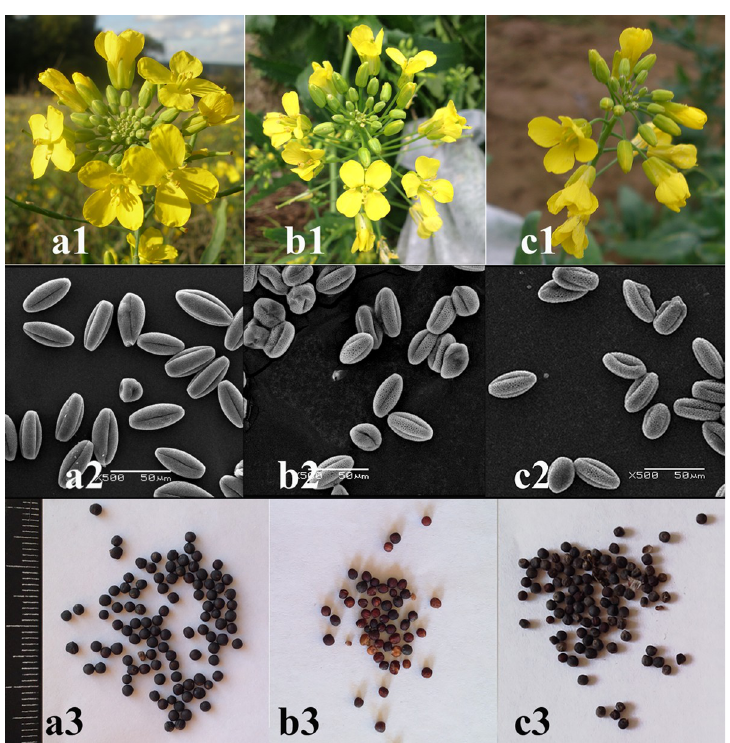
Fig 2. Vegetative parameters in B . napus cv. Vikros and mutant plants. Inflorescences of B . napus cv. Vikros (a1), plants of B . rapa -type (b1) and B . napus -type (c1); SEM images of pollen grains in B . napus cv. Vikros (a2), in plants of B . rapa -type (b2) and B . napus -type (c2); seeds of B . napus cv. Vikros (a3), plants of B . rapa -type (b3) and B . napus - type (c3). Scale bar– 50 μ m.